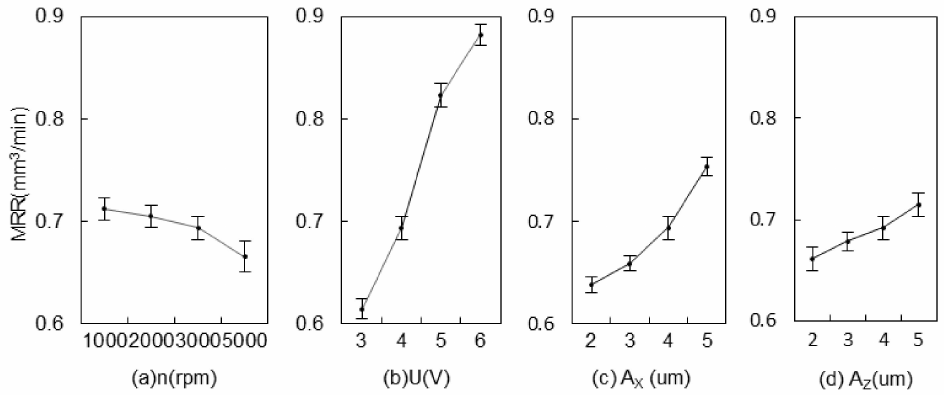
Figure 11. Effects of machining parameters on MRR.